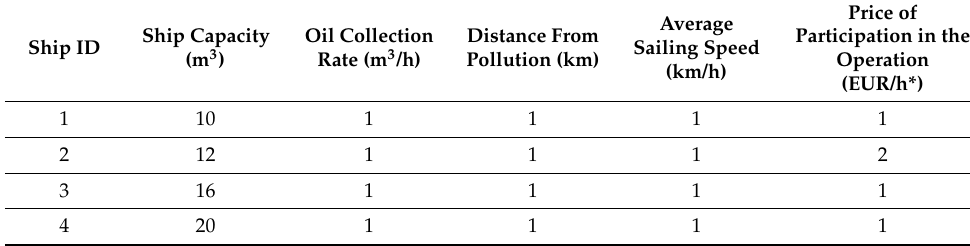
Table 7. Example 2—input data. The price (EUR/h*) is hypothetical.